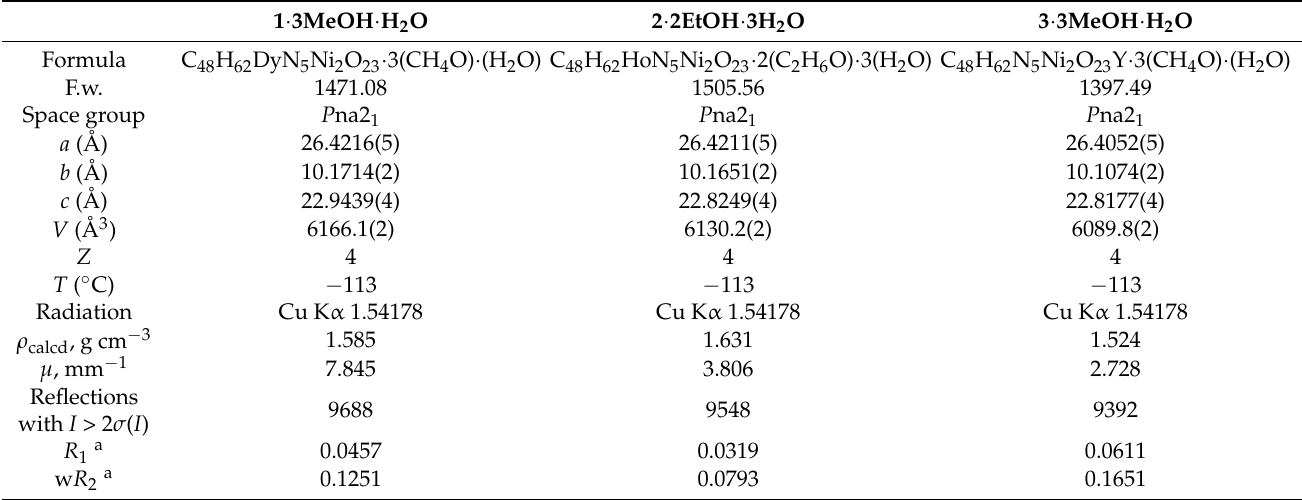
Table 1. Crystallographic data (see Appendix A) for 1 · 3MeOH · H 2 O, 2 · 2EtOH · 3H 2 O and 3 · 3MeOH · H 2